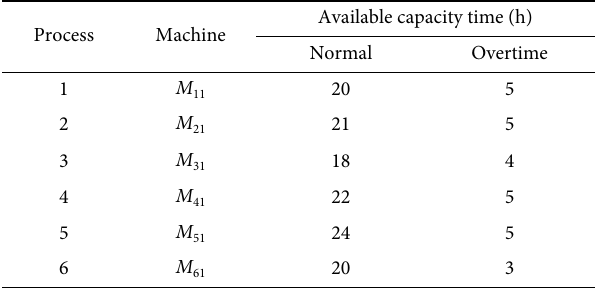
Table 3 Available capacity time.